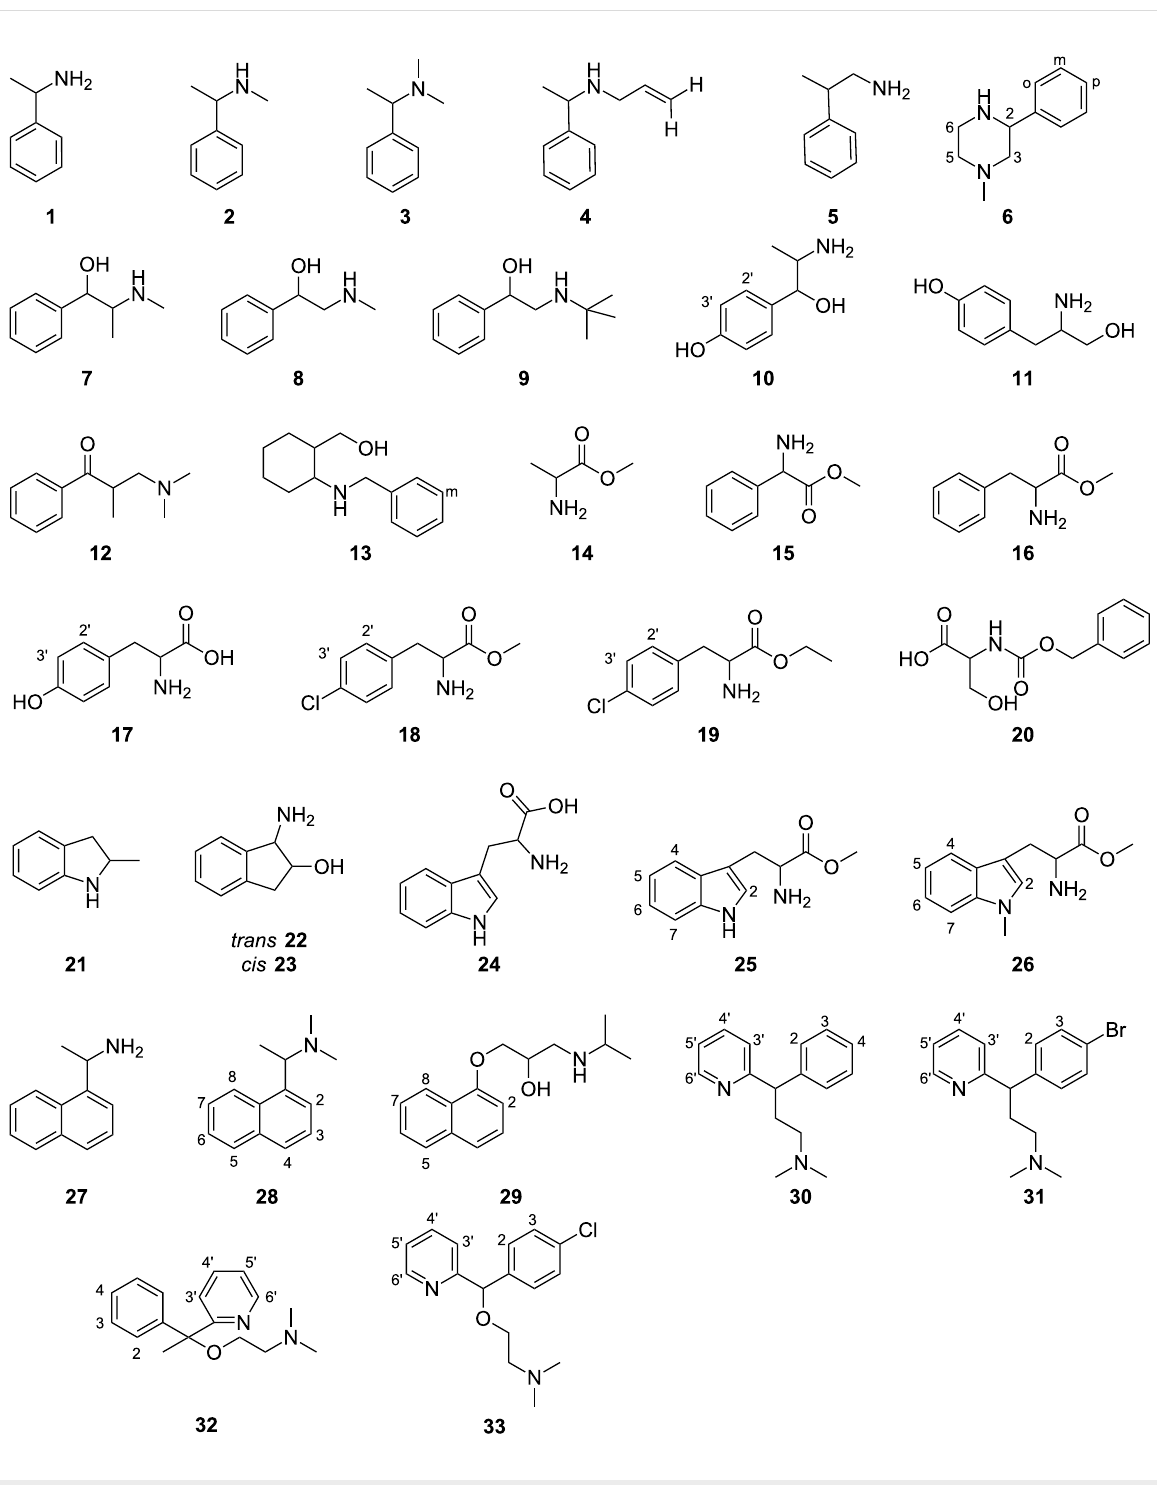
ring. The largest magnitude of enantiomeric differentiation ob- served in the 1 H NMR spectra of the substrates with each P-CD at 5, 10 or 20 mM (P- α -CD-L DS , DS = 2–6; P- α -CD-H DS , DS =